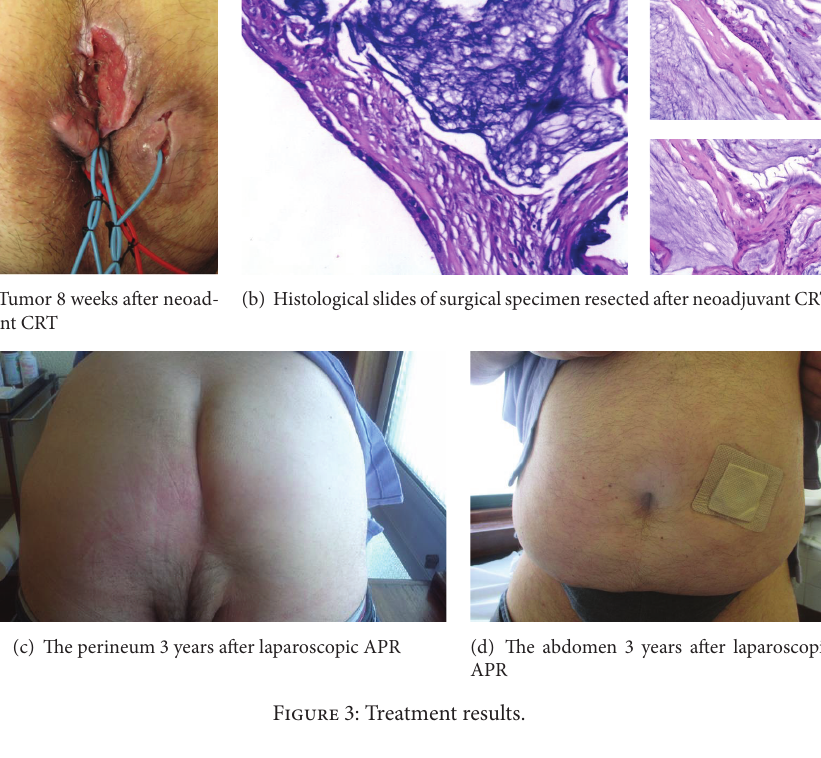
Figure 3: Treatment